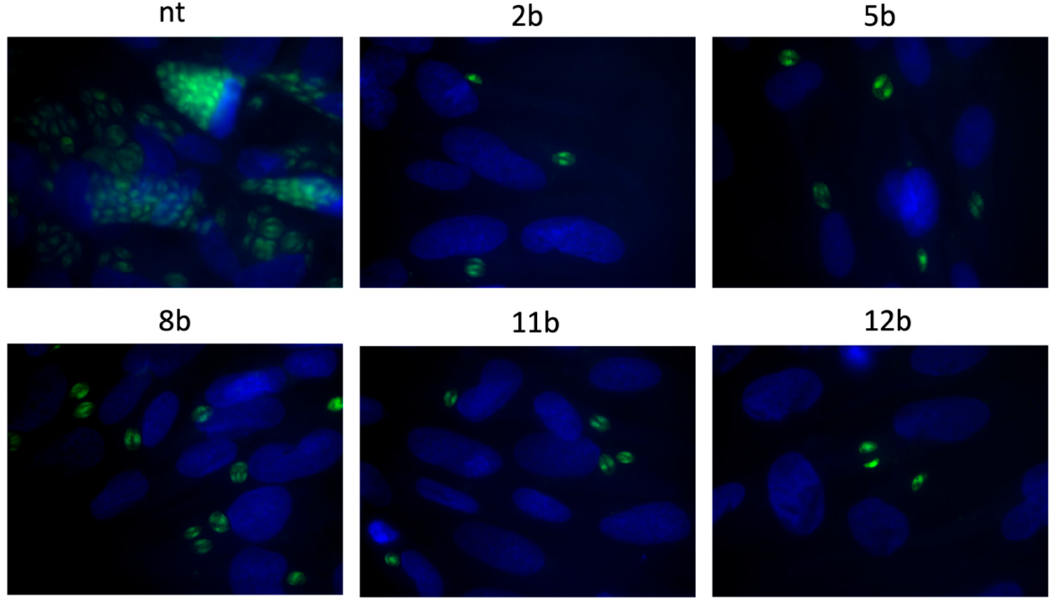
Figure 10. Representative images from assay B. Impeding tachyzoites division in host cells after 24 h incubation with tested 1,3,4-thiadiazoles 2b , 5b , 8b , 11b or 12b ; T. gondii —green, cell nuclei—blue; NT—not-treated.